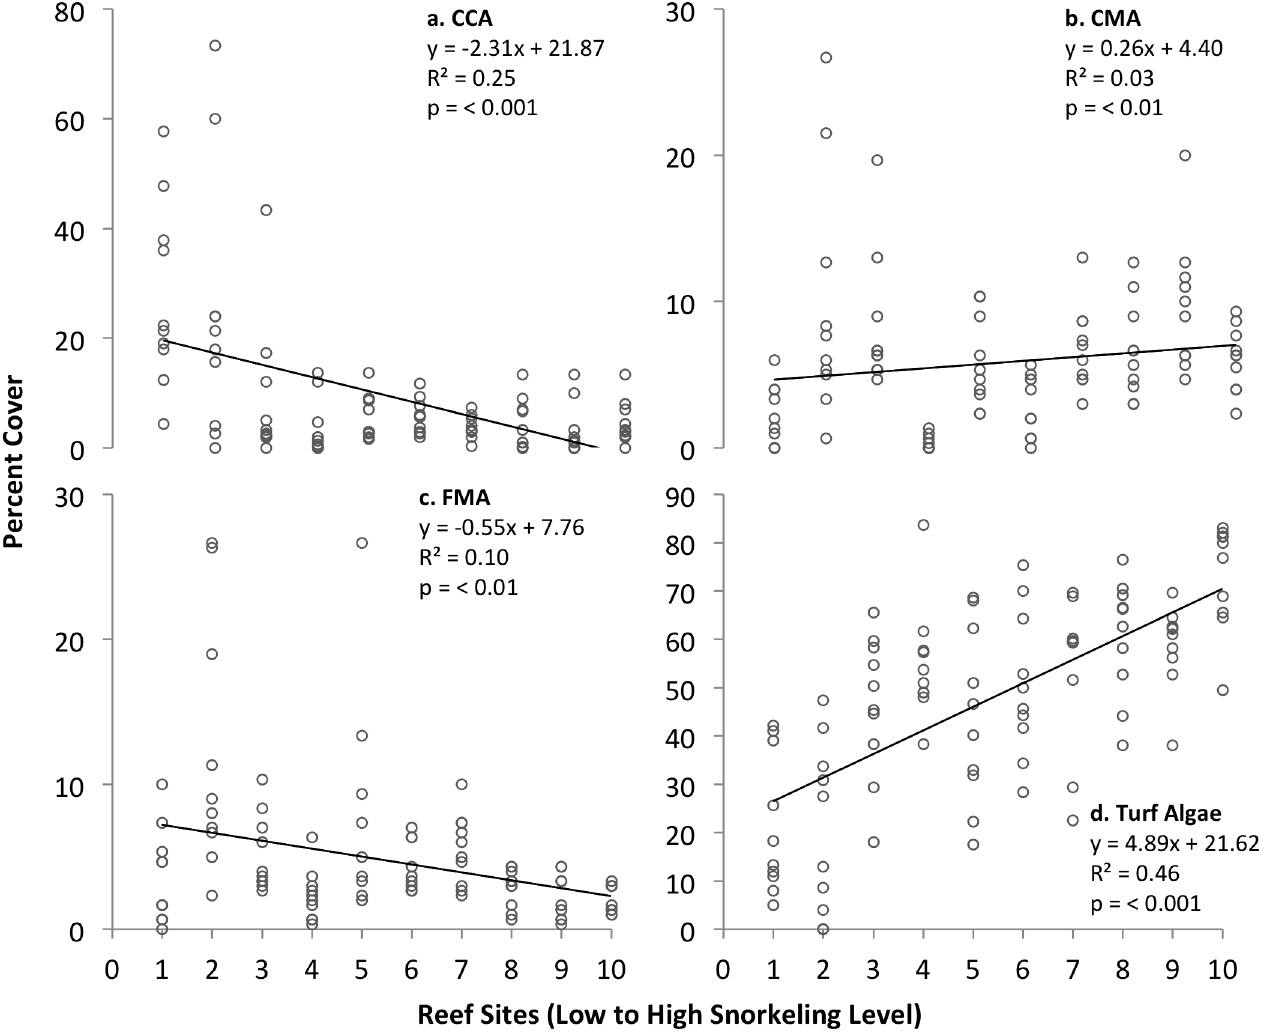
Fig 6. Growth form variation in the percent cover of macroalgaeamong patch reefs ranked by level of snorkeling in Akumal Bay, Mexico. CCA = Crustose corallinealgae, CMA = Calcifiedmacroalgae, FMA = Fleshy macroalgae. N = 10 transects examinedper reef.